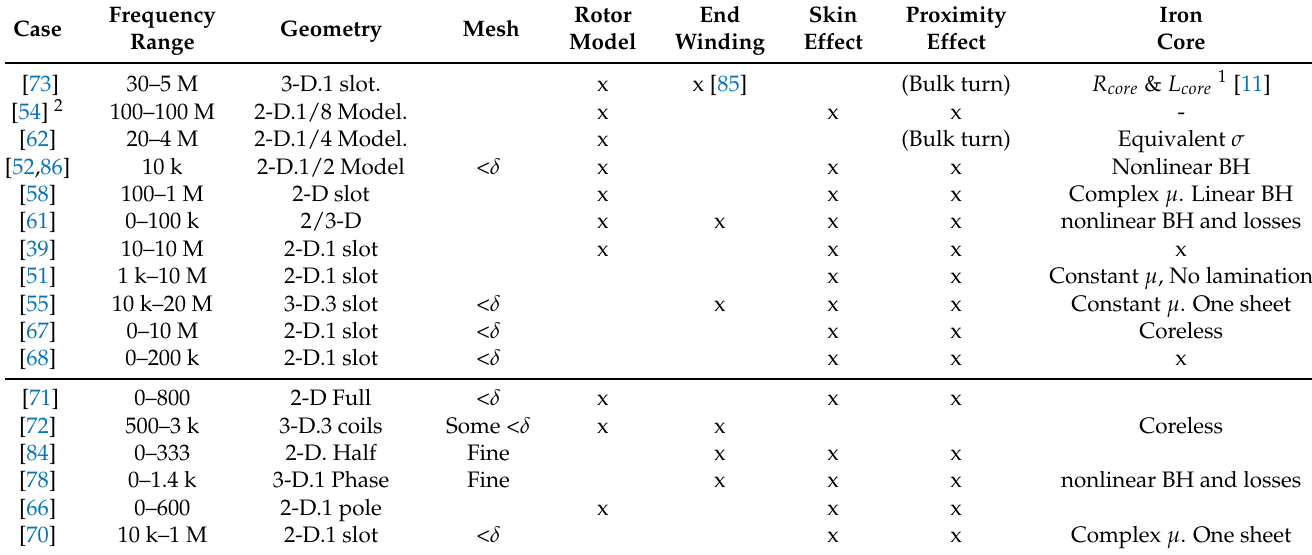
Table 1. FEM Electromagnetic simulation